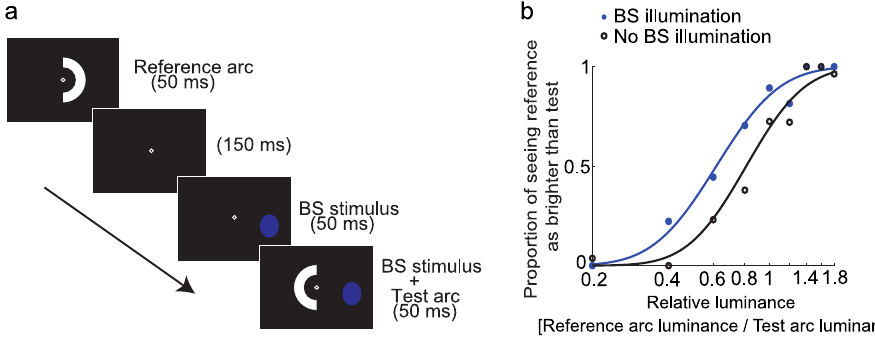
Figure 1. Procedure of Experiment 1 to determine brightness with and without the illumination of the blind spot (BS). ( a ) Brightness-matching task. Observers were asked to judge whether the test arc was brighter or darker than the reference arc. In half of the trials, a blue oval was presented within the blind spot when the test arc appeared. ( b ) Psychometric functions of a representative observer. The proportion of trials in which the reference arc appeared brighter than the test arc is plotted as a function of relative luminance (reference arc luminance/test arc luminance), with (blue) and without (black) BS illumination. Note that the function of the ‘No BS illumination’ condition was not necessarily centred at 1 along the abscissa. This was because the experiment allowed a constant error to originate from the fixed spatiotemporal setup, wherein the reference arc was first presented in the right hemifield, followed by the test arc in the left hemifield. Under BS illumination, the psychometric function shifted leftward from the control condition, indicating that the test arc had become darker